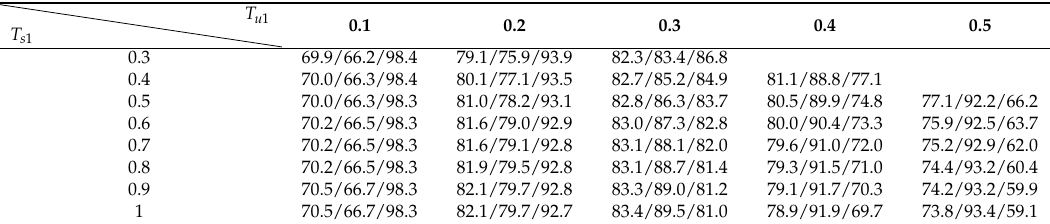
Table 2. Overall accuracy (%)/user’s accuracy (%)/producer’s accuracy (%) as a function of T s 1 and T u 1 . T s 1